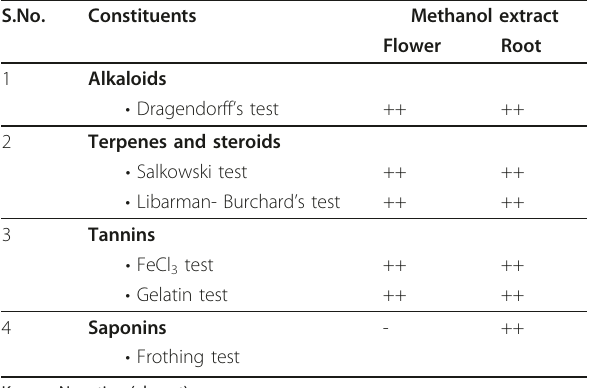
Table 1 Phytochemical screening of methanol extract of flower and root of Pyrostegia venusta (Ker-Gawl.) Miers S.No.